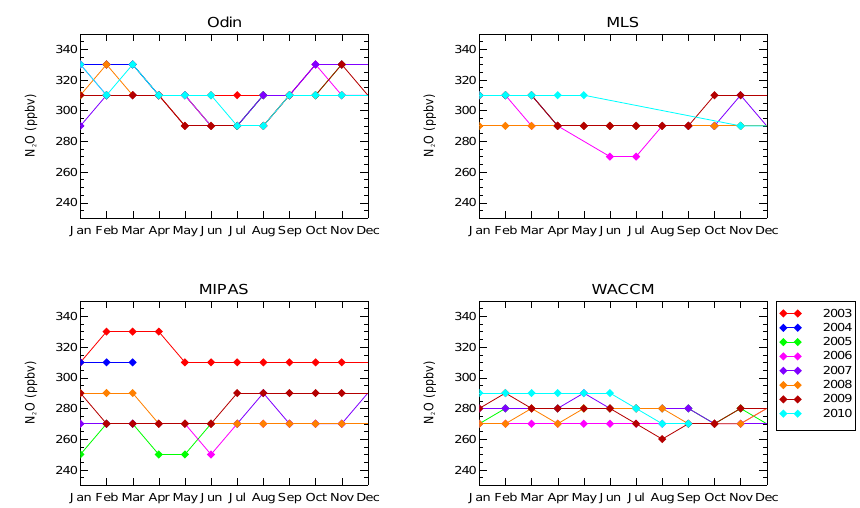
Fig. 7. Maximum monthly averaged N 2 O mixing ratios (averaged mixing ratio of the last N 2 O bin) at 650 ± 25K are shown for Odin/SMR, Aura/MLS, ENVISAT/MIPAS and SD-WACCM (Visualization of the data presented in Tables 1 to 4 of the Supplement).